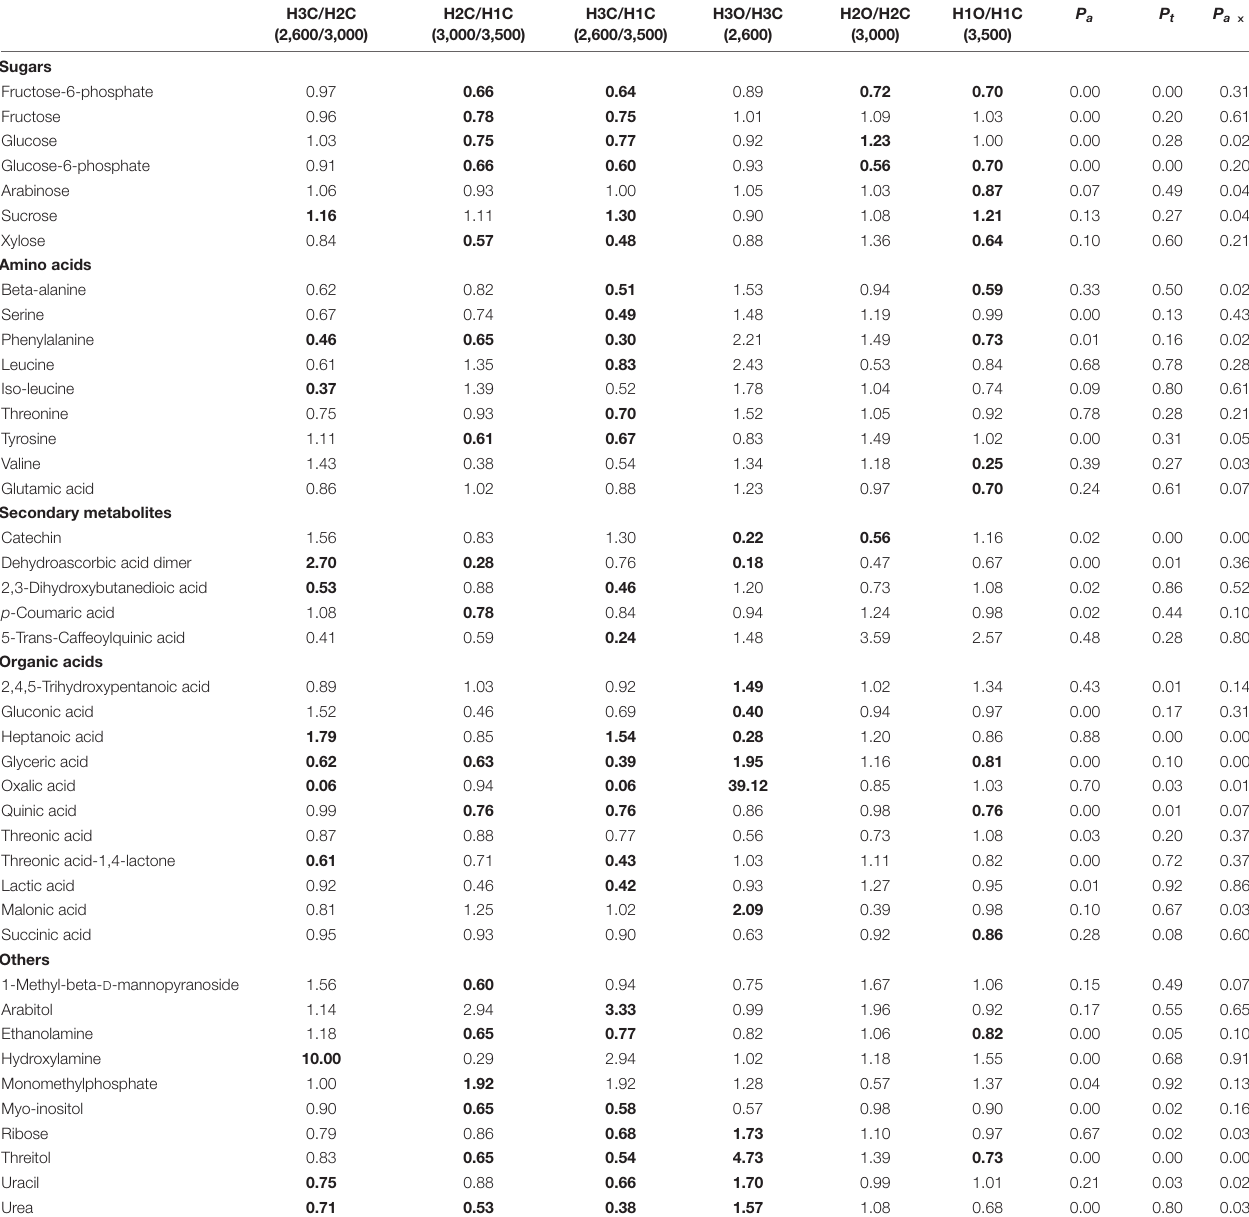
TABLE 3 | The significant fold changes of differentially expressed metabolites (DEMs) in needles of A. faxoniana as affected by altitude and warming.